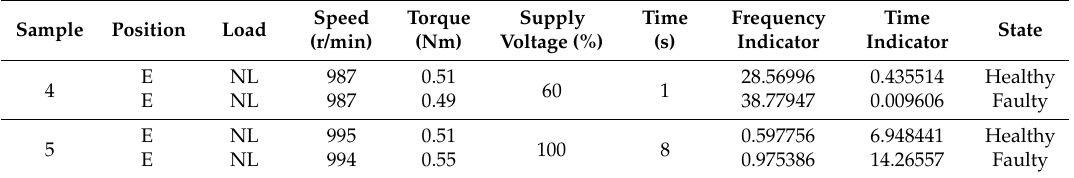
Table 16. Results of the time and frequency indicators for the E position.